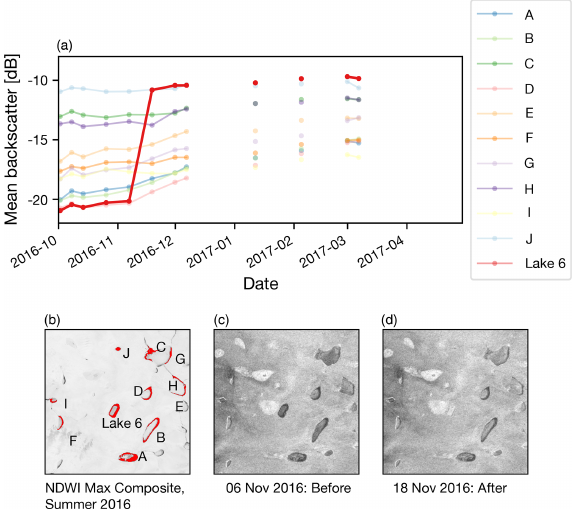
Figure 5. (a) Sentinel-1 backscatter time series for the largest 10 lakes within 10km of Lake 6. Connective lines are omitted from the time series graph when the time between images is greater than 12d. Image (b) is a composite maximum NDWI ice image for late summer 2016, prior to lake drainage showing the lakes included in the graph above. Images (c) and (d) are Sentinel-1 backscatter images for 6 and 18 November 2016 across which the drainage of Lake 6 is observed. While the backscatter of the surrounding lakes undergoes a small gradual increase over time, the backscatter in- crease of Lake 6 is much greater than that seen in the other lakes.